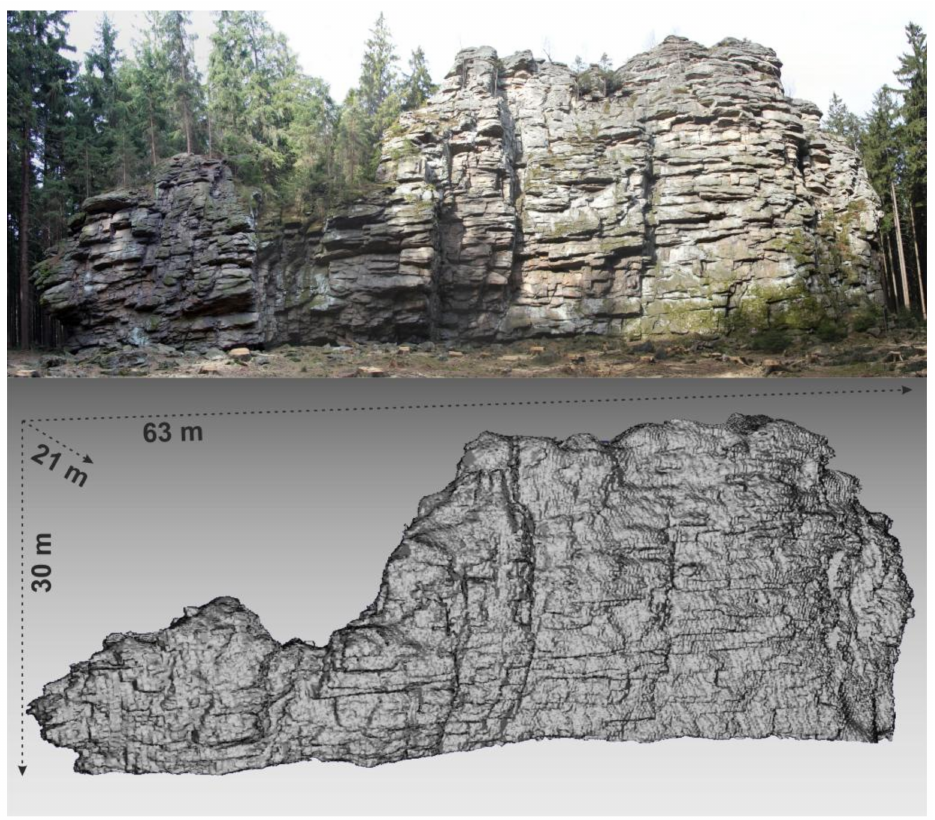
Figure 5. The real form of the B í l á sk á la rock formation ( above ) and a 3D model with dimensions ( below